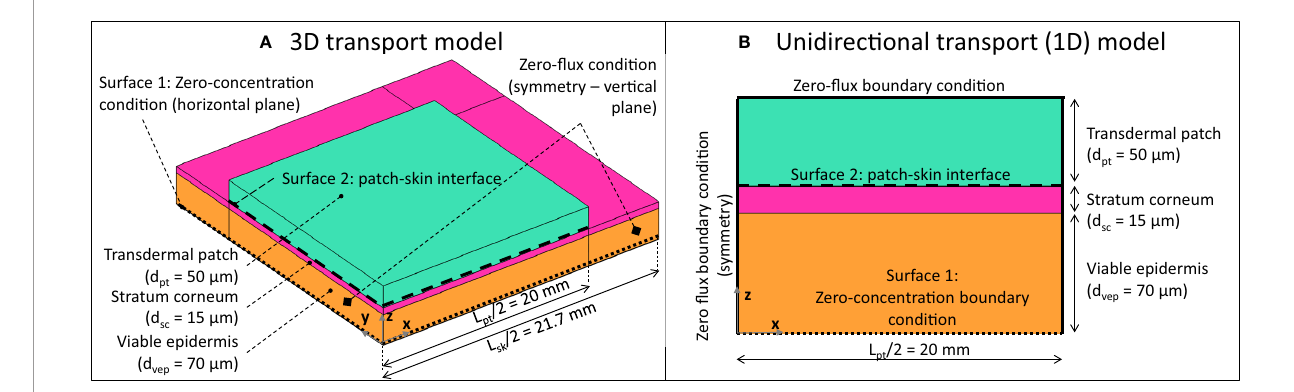
FIGURE 2 | 3D (A) and 1D (B) geometrical models of square-shaped drug reservoir and skin (not to scale; for 3D model, only one-fourth of the system was modeled due to the symmetry).